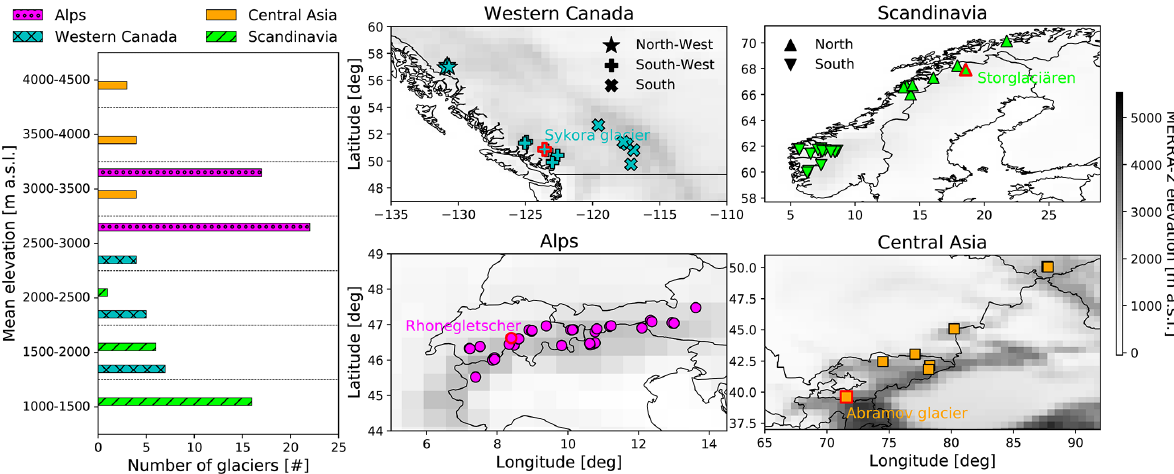
Figure 1. Mean elevation and distribution of the glaciers used in the study (data source: WGMS, 2021). Glaciers shown in Fig. 7 are highlighted in